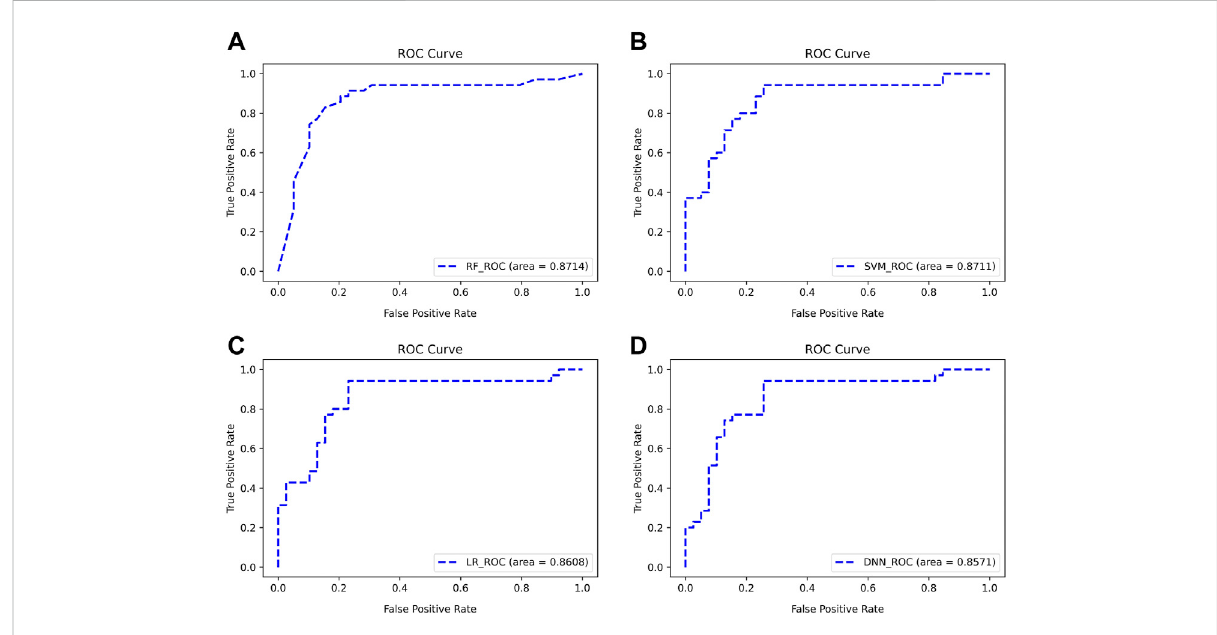
FIGURE 10 ROC curves for classifying subjects using Top features (A – D) . The classi fi ers used are RF, SVM, LR, and DNN, respectively.